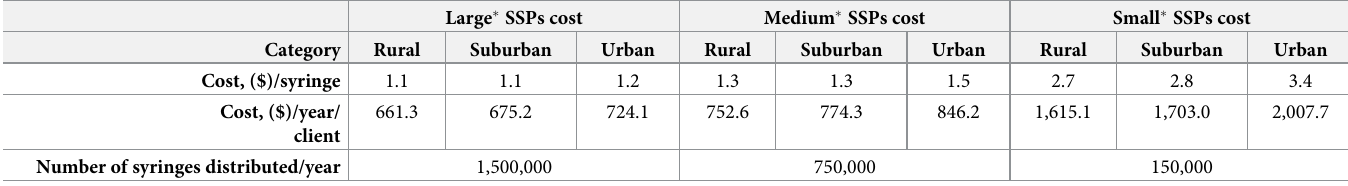
Table 2. Estimated per syringe and per client costs of a comprehensive syringe service program (SSP) by size and geographic location, United States (in 2016 US